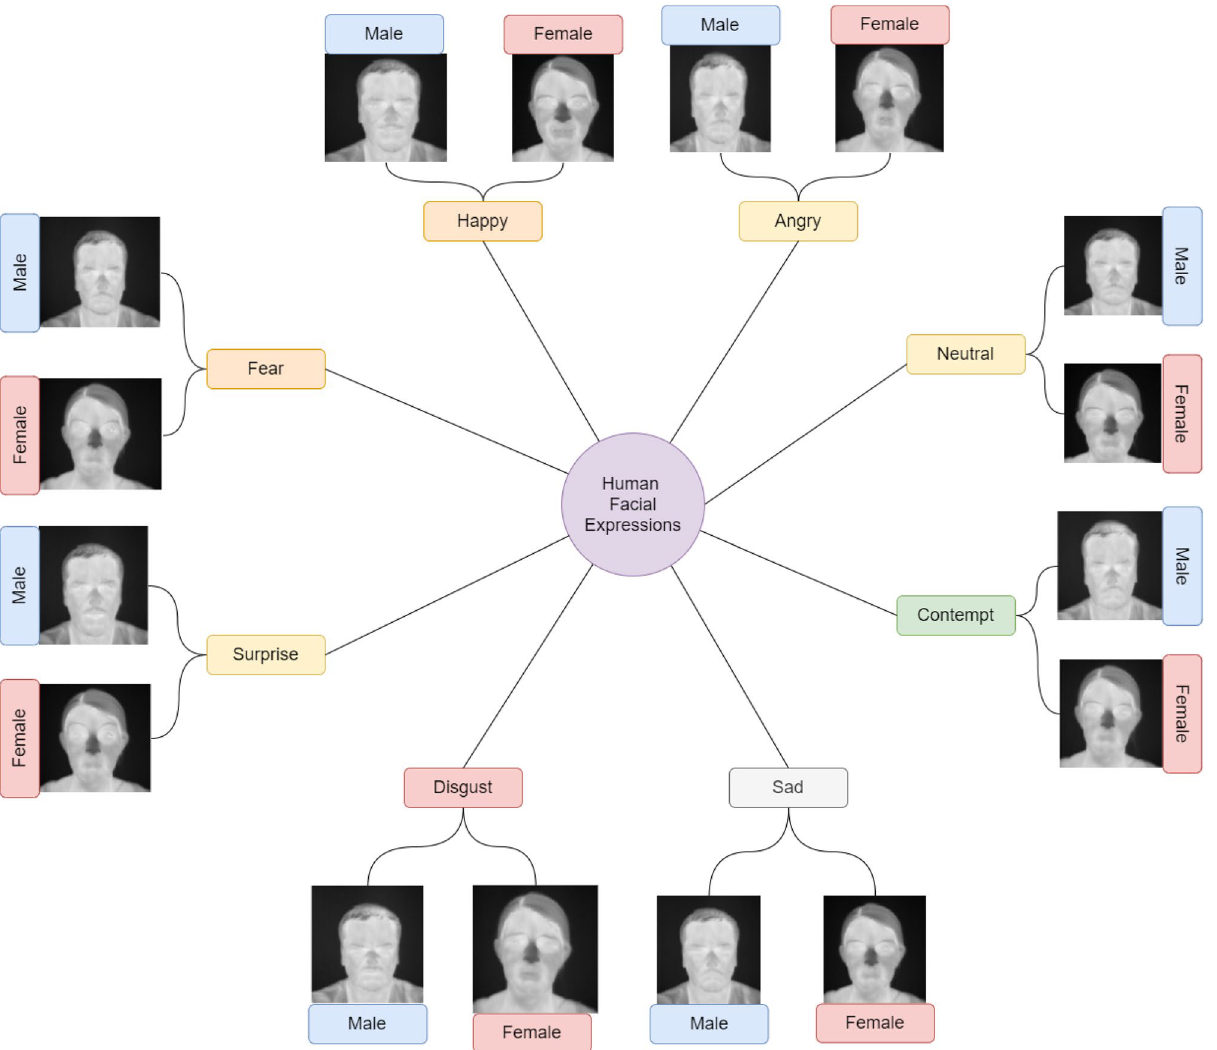
Figure 1. Sample images representing all eight expressions, happiness, sadness, surprise, fear, disgust, anger, contempt and neutral for males and females. Image is developed using Draw.io 32